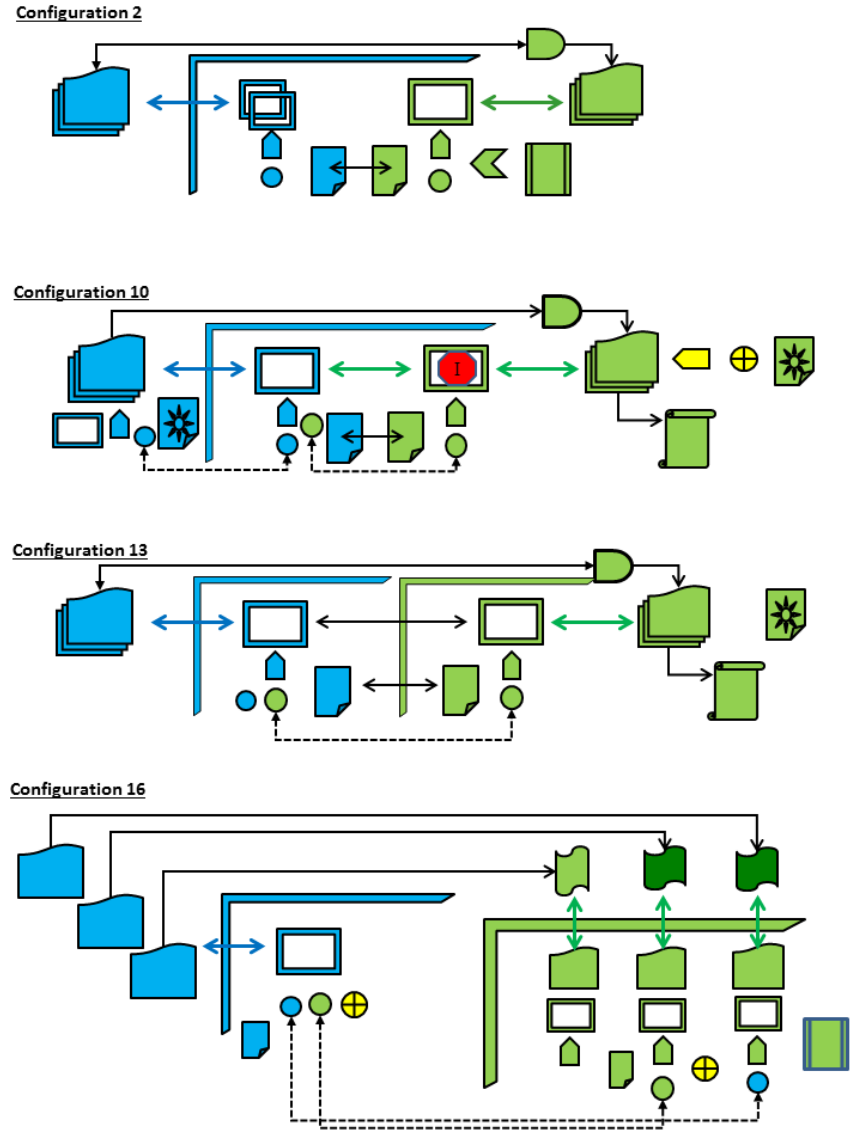
Figure 5. A selection of four configurations using elements from Figure 4 (a complete collection of configurations are found in Figure S5). In Configuration 2 (from Category I) all training takes place in the control room of the plant. An un-supervised set-up where the control room been extended with several screens. OTS model is provided with an accelerator function to reduce training time. In Configuration 10 (from Category II) training takes place partly in the plant hall. Real incident occurs in real process and trainer reproduces this in the OTS interface for the trainee to act upon. In Configuration 13 (from Category III) training is carried out in a room aside the control room and the plant, here with a more advance training with models. In configuration 16 (from Category IV) a distributed simulator setup is configured from existing software programs with extended modeling and simulation capacity for selected parts of the plant. Independent unsupervised training in takes place in the plant